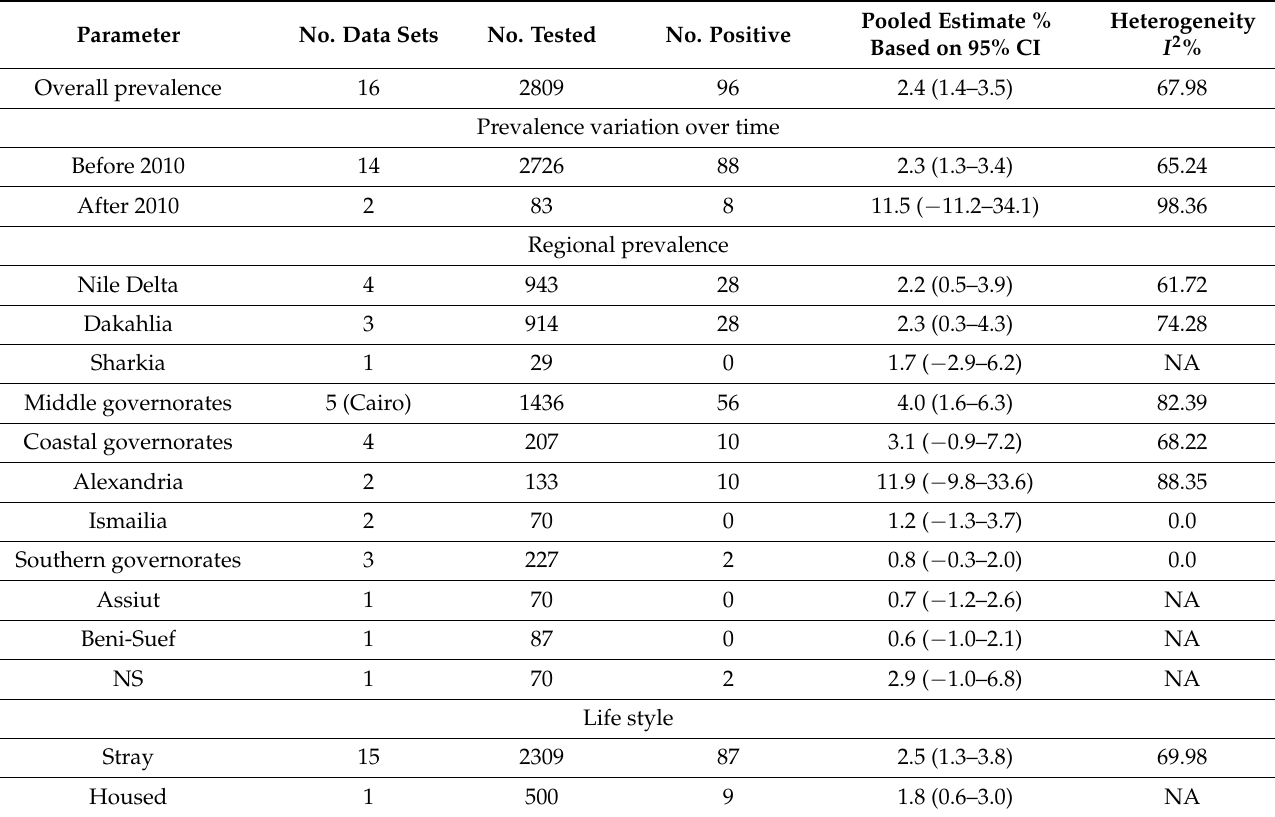
Table 7. Overall and regional prevalence of Echinococcus granulosus detected in dogs from various Egyptian regions, and variabilities according to dog life style.